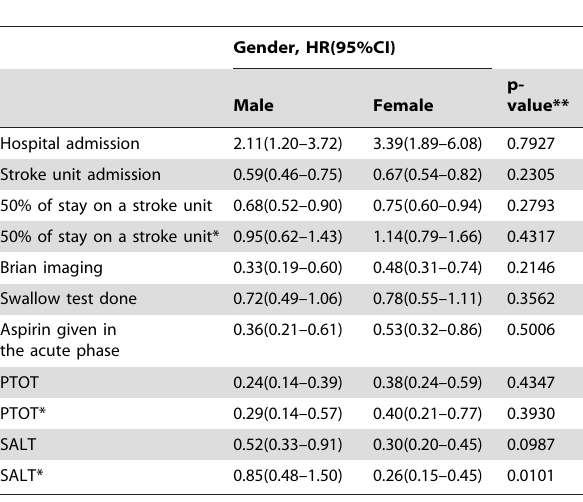
Table 3. Relative hazard of death following receipt of acute care interventions by